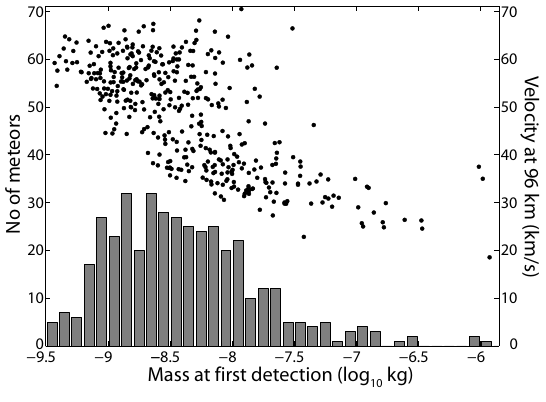
Fig. 9. Distribution of estimated meteoroid masses at detection and a scatter plot of velocity versus mass.